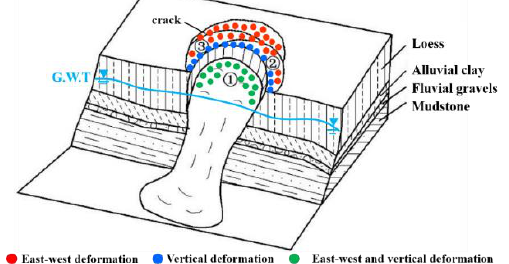
Figure 5. A conceptual model of the multi-staged retrogressive failure of loess